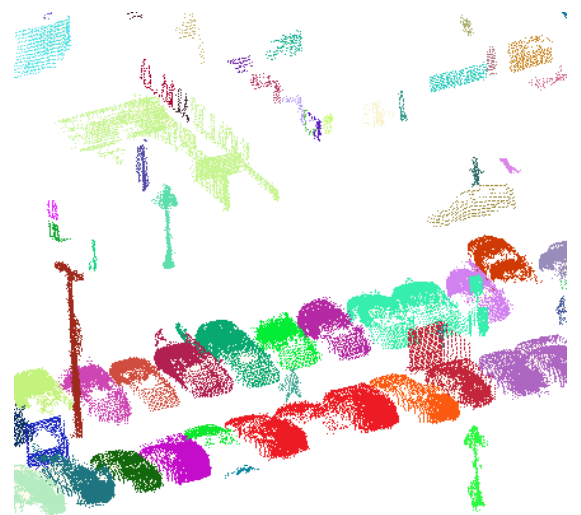
Figure 5: Typical result of the hypotheses generation stage. Dif- ferent colors denote different connected components. The red